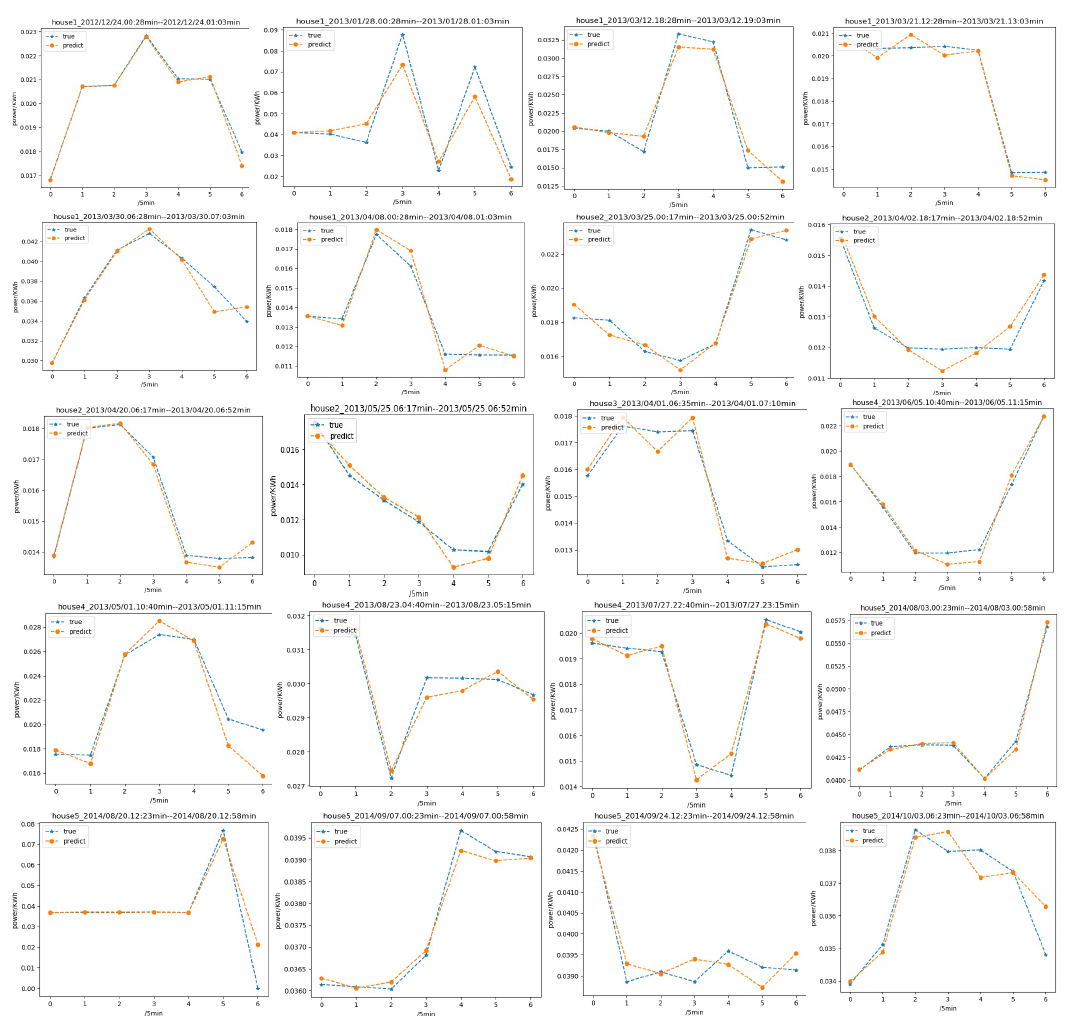
Figure 7. Twenty groups of k -step ( k = 6) power consumption forecasting results for different household datasets, showing the performance and robustness of the proposed CNN-LSTM